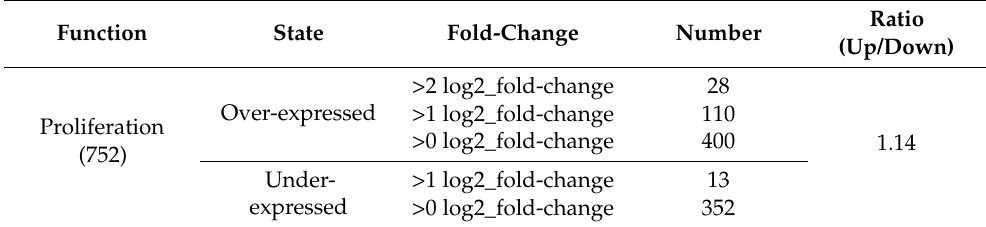
Table 1. Distribution of detected DEGs involved in cell proliferation based on different log2-fold-